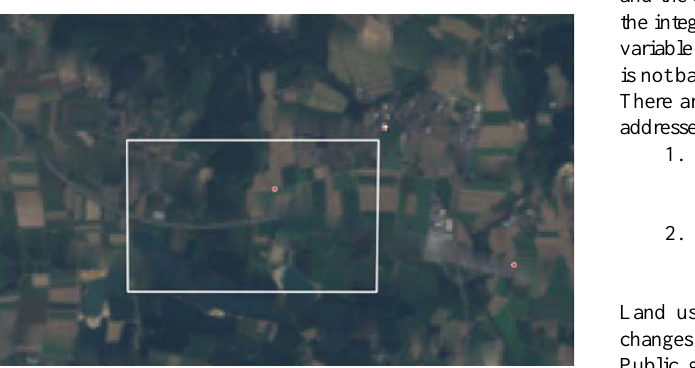
Figure 10 Detail of a Landsat image for day 271 year 2013 (white rectangle indicates borders of the aerial image from Figure